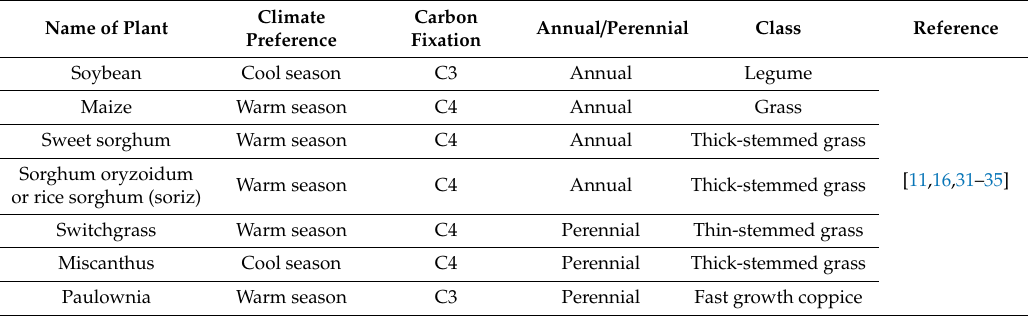
Table 1. The basic characteristics of the bioenergy crops.